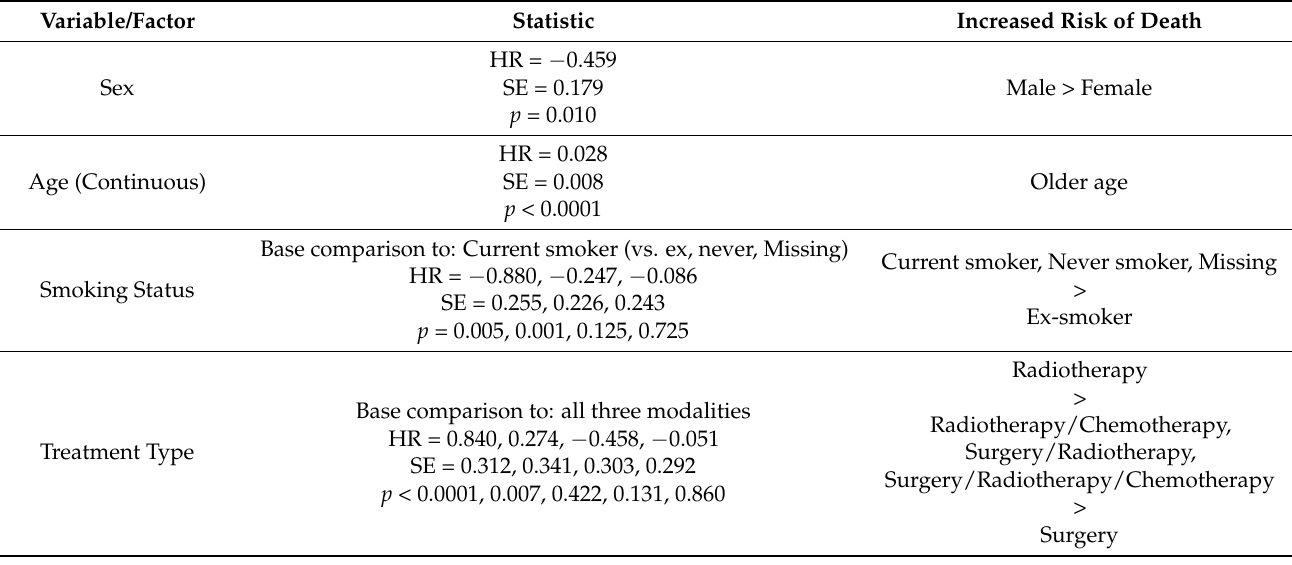
Table 9. Patient and tumor characteristics significantly predicting disease-specific (cancer-specific) survival amongst oral cavity cancer patients by multivariable Cox proportional hazard model. The initial model included all those variables significant by univariable.